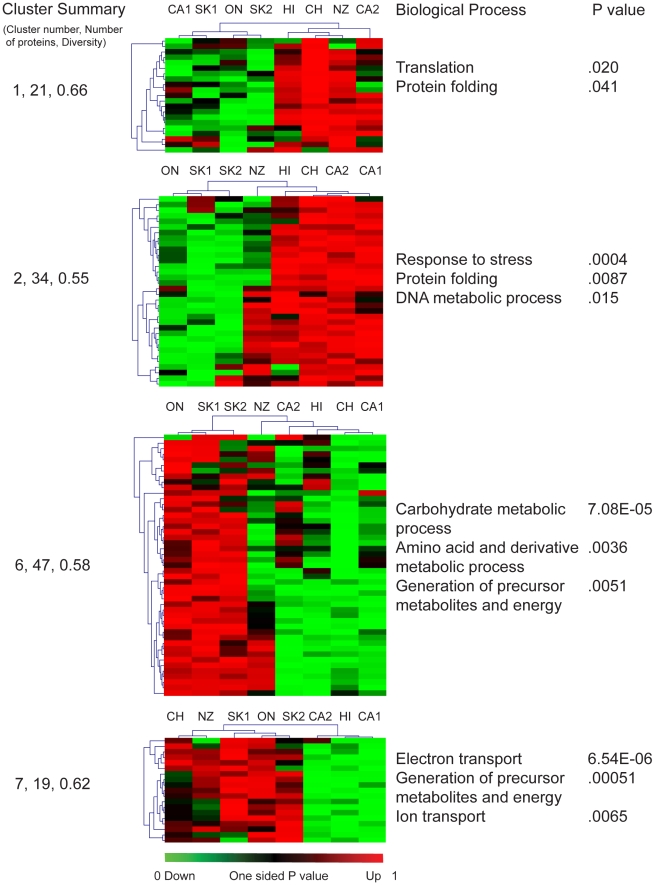
Results of clustering of all midgut proteins found differently expressed for any population.The 172 proteins with a significant population effect were grouped using the SOTA into eight clusters based on their one-sided P-values; the four clusters exhibiting significant enrichment in functional classes of proteins are shown. The proteins within each SOTA cluster were further clustered hierarchically by both protein (vertical) and population (horizontal). The cluster number, number of proteins, and diversity is given to the left. GO terms for biological processes found to be significantly enriched (FDR Corrected P>.05 Hypergeometric test) in each cluster are shown to the right.